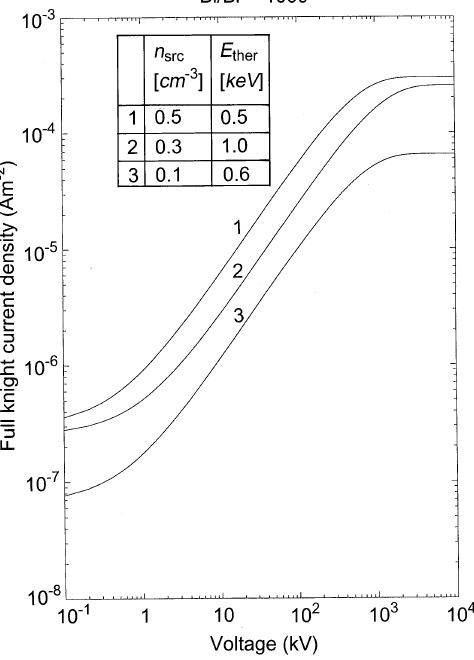
Fig. 1. Plot showing the full Knight current density versus potential drop for different source densities and thermal